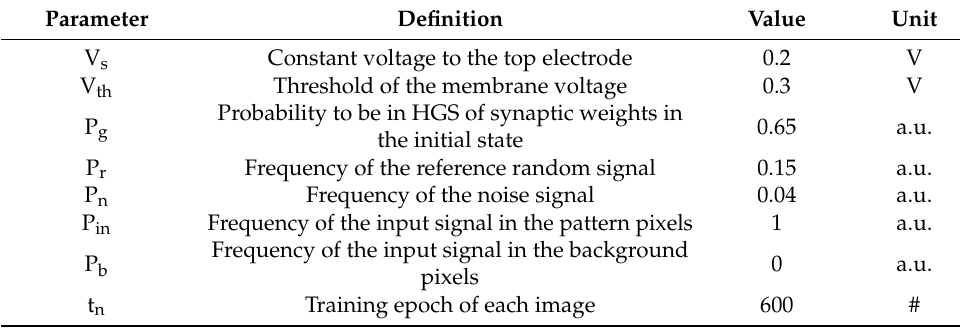
Table 1. The optimized network parameters.